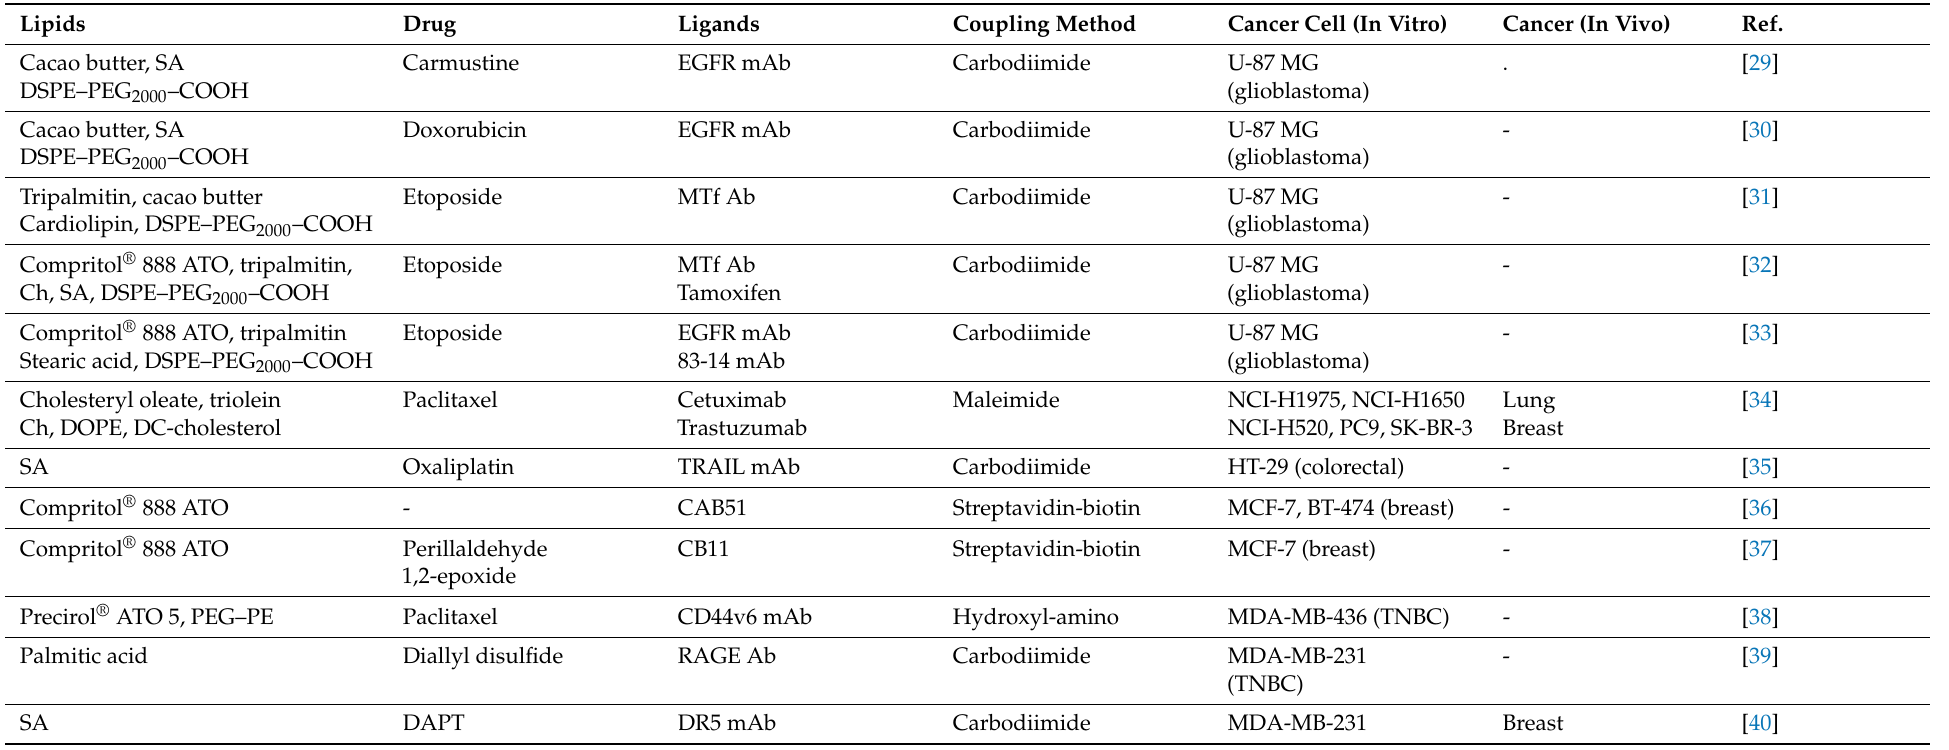
Table 1. Antibody-functionalized SLN for anticancer drug